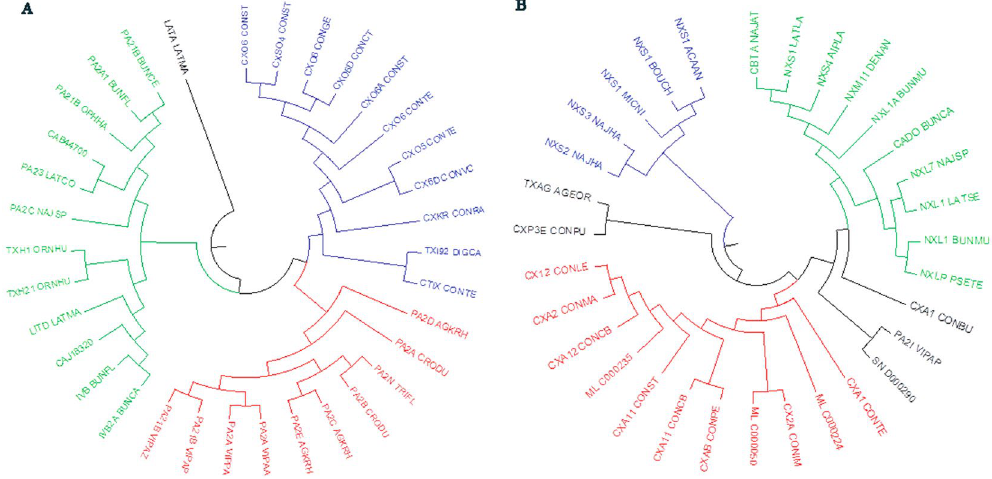
Figure 1. The phylogenetic trees for ( A ) presynaptic neurotoxins and ( B ) postsynaptic